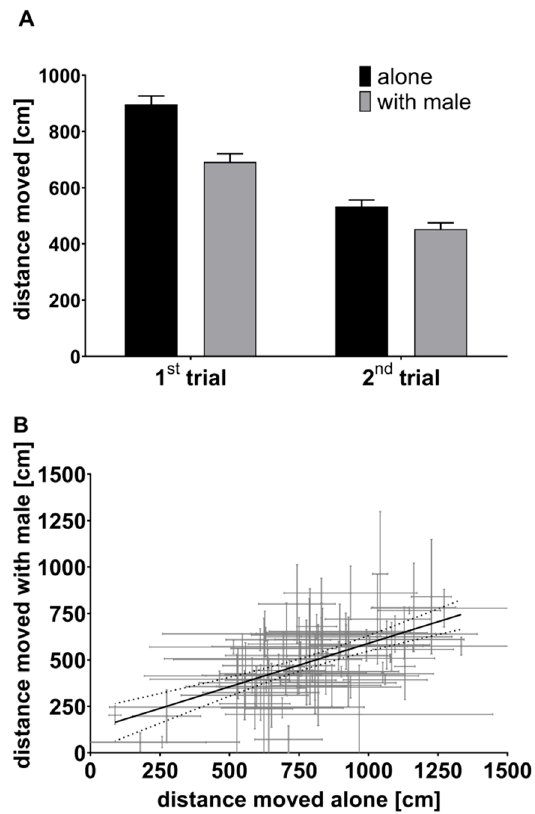
Figure 2. ( A ) Distance moved by females. Mean distances for both trials (1st and 2nd) are shown as well as for the treatments (female alone or with a male partner). ( B ) Consistency in female swimming activity across treatments. A scatter plot with individual ‐ level error bars and a linear line of best fit (with 95% CI, dotted lines) is shown for female distances moved in an open field arena both alone and with a male partner. Error bars represent standard error (SEM) ( A ) and SD ( B ).